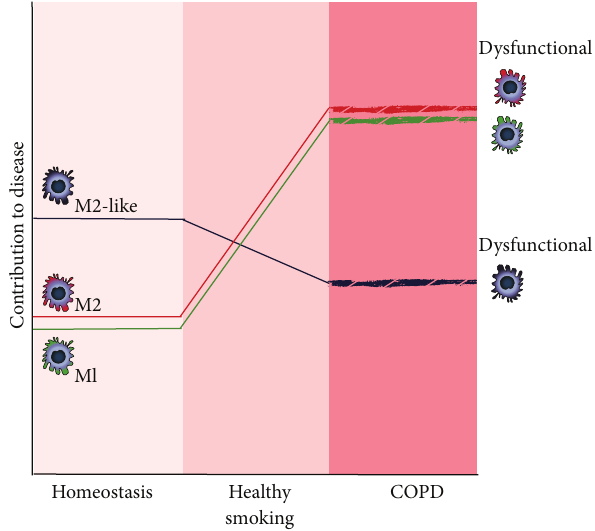
Figure 3: Schematic representation of the presence of M1, M2, and M2-like macrophages in lung tissue during homeostatic conditions, during healthy smoking, and in COPD. Please note the dysfunc- tional state of macrophages during